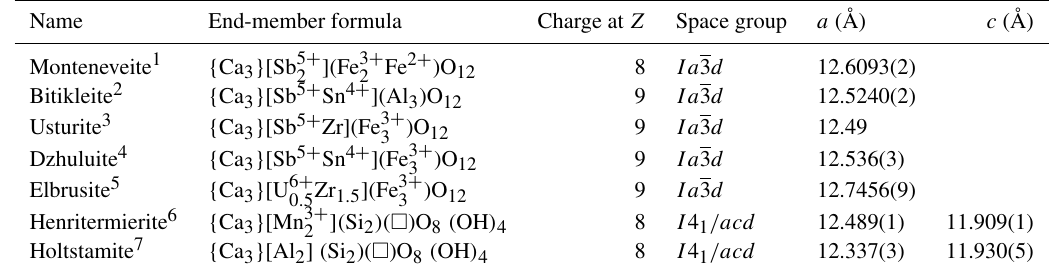
Table 8. Comparison of monteneveite to other related species in the garnet supergroup.